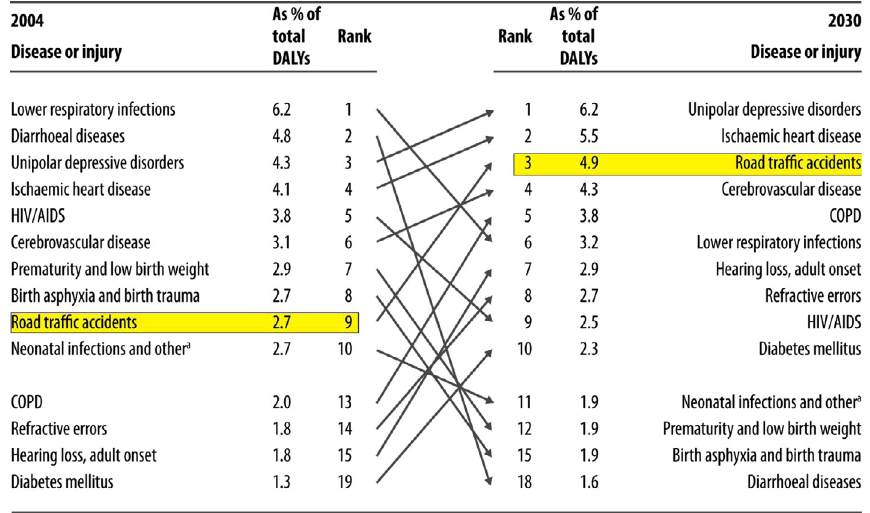
Figure 3. Table comparing the DALYs ranking between 2004 and 2030